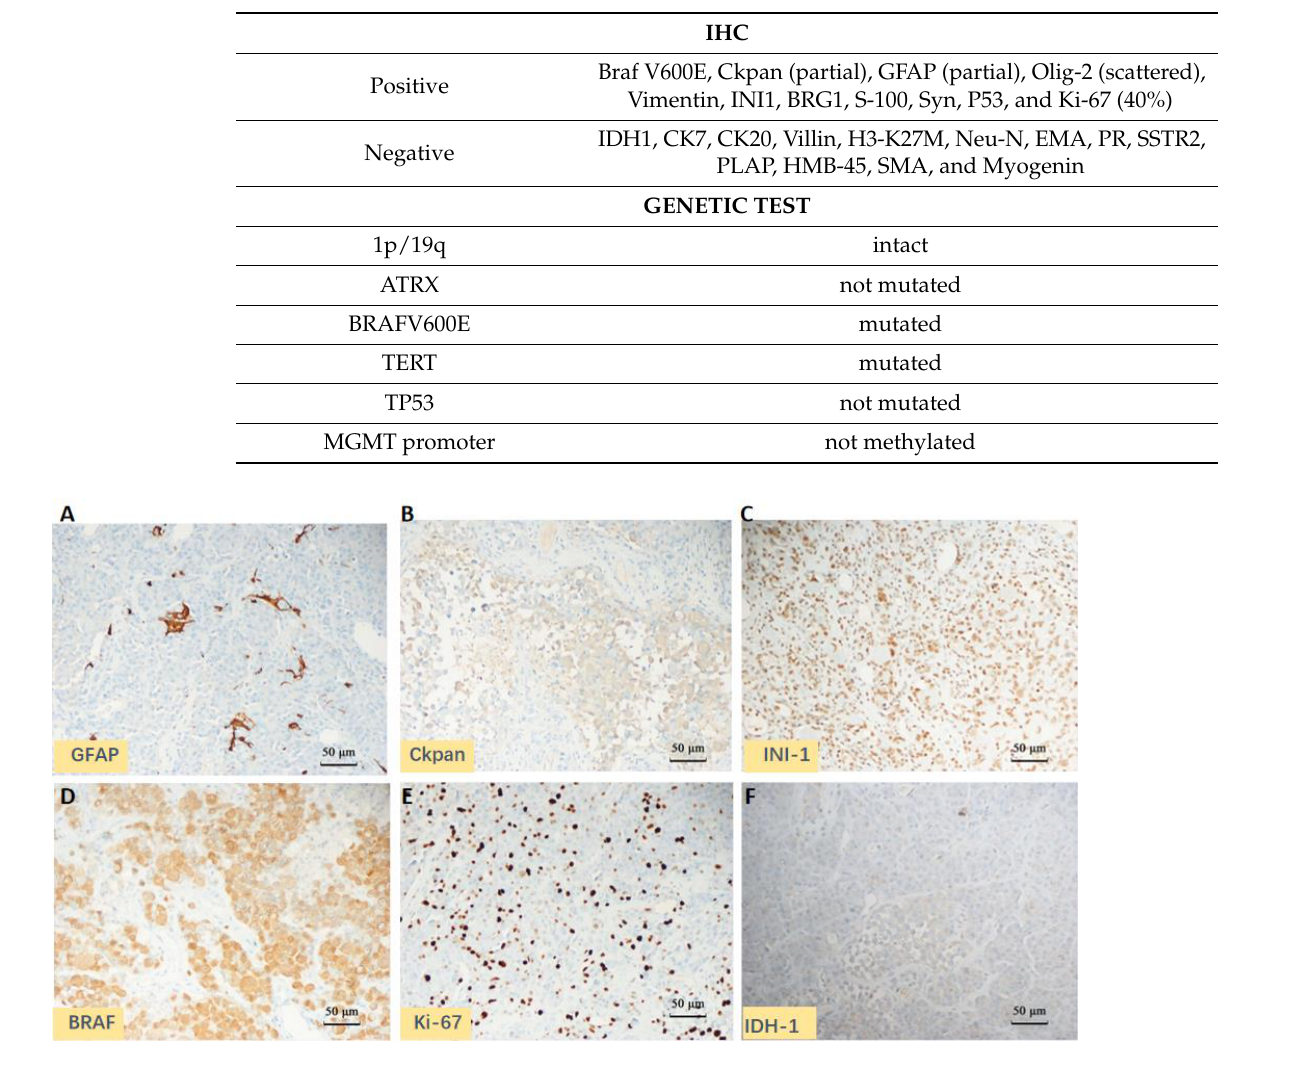
Table 1. Summary results of immunohistochemistry and genetic tests.